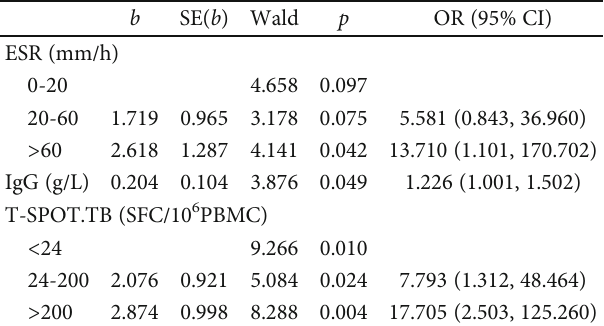
Table 3: Potential risk factors for ATB in BD